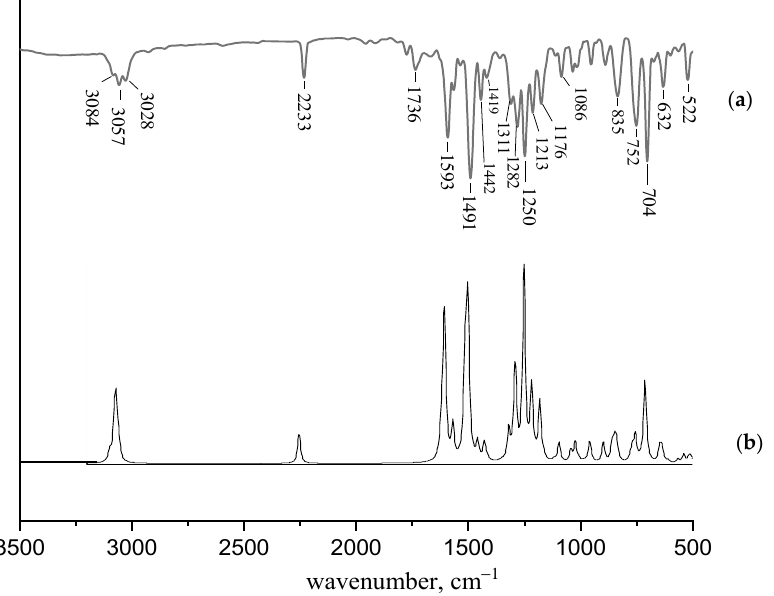
Figure 7. Experimental FTIR spectrum for the film of TPPN ( a ), and calculated spectrum for a mixture of cis- and trans -conformers ( b ).